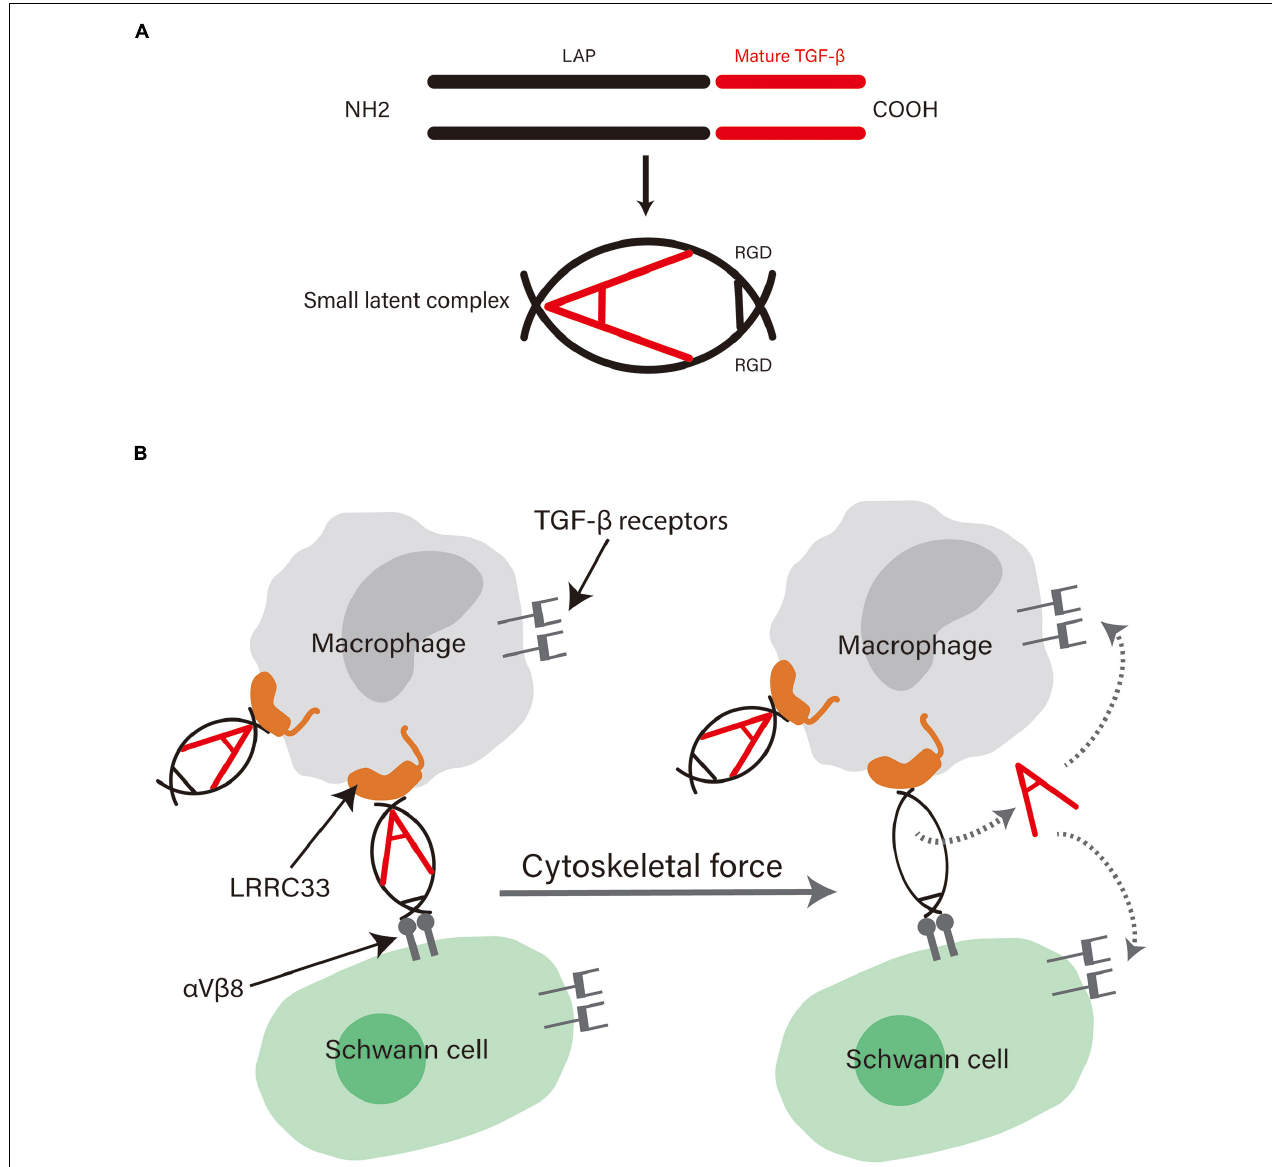
FIGURE 1 | (A) The structure of pro-TGF- β . Pro-TGF- β is an inactive complex comprising a LAP and a mature cytokine. The LAP surrounds the mature cytokine and blocks its binding to receptors. Adapted from Travis and Sheppard (2014) and republished with permission from Annual Reviews, Inc. (B) The possible mechanism behind the role of TGF- β in the supportive effects exerted by macrophages on SCs. α V β 8 integrins on SCs can bind with high affinity to the Arg-Gly-Asp motif in the LAP and LRRC33 on macrophages bind to the other side of it. The physical force generated by contraction of the actin cytoskeleton of cells distorts the LAP